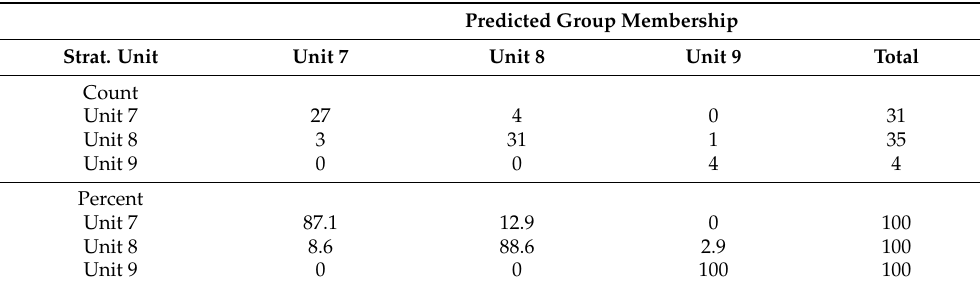
Table 4. Summary of samples from chemostratigraphic units in legacy deposits that were correctly classified by discriminant analysis.